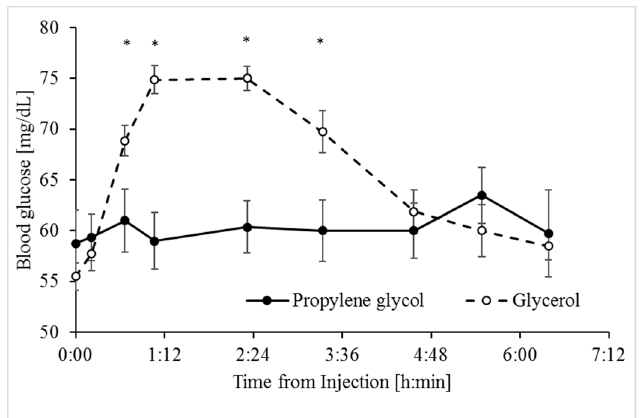
Figure 2. Glucose response to the propylene glycol and glycerol treatments. Analyses indicate the effects of Treatment, Time, and Treatment × Time interaction (Table 1). * Significant difference at α = 0.008 after Bonferroni correction. SEM = 0.974. Values represent mean ± SE.